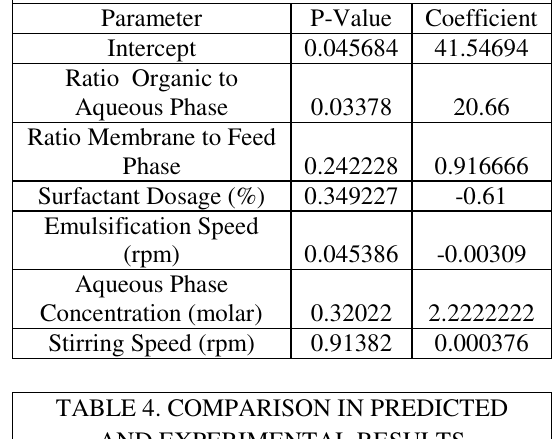
TABLE 3. PARAMETERS WITH THEIR P-